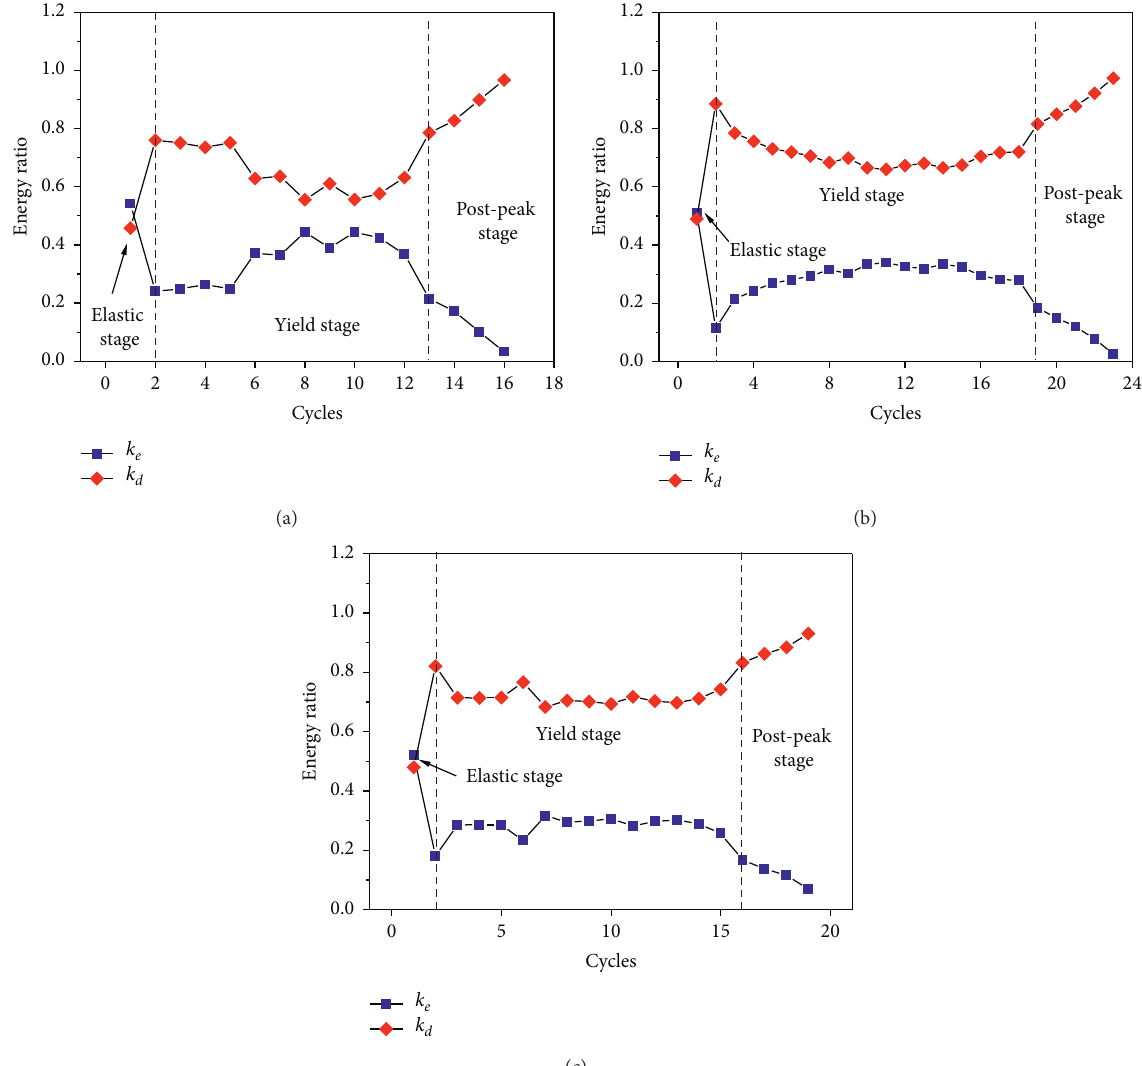
Figure 7: Evolution characteristics of proportion of elastic and dissipative energy. (a) f-1; (b) f-2; (c) f-3.